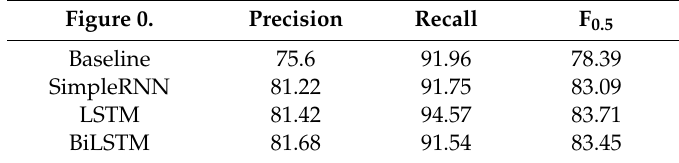
Table 7. Results of Best Configuration When Trained on Augmented Dataset. Figure